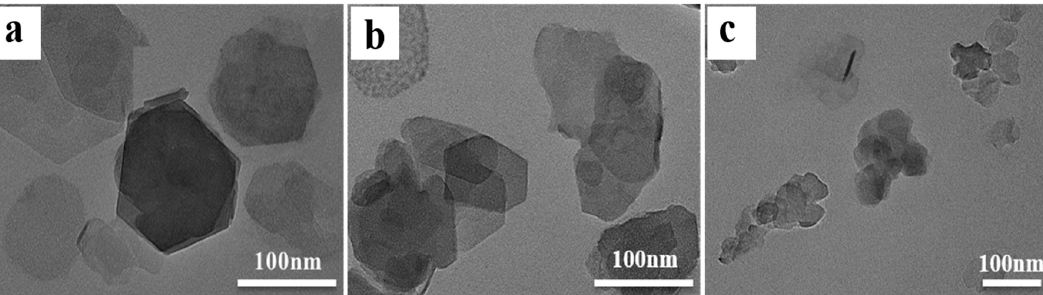
Figure 1. XRD patterns of LiAl-LDHs prepared from brine at varied initial Li + concentrations ( a ) 6.75 g/L, ( b ) 3.375 g/L, ( c ) 1.6875 g/L.